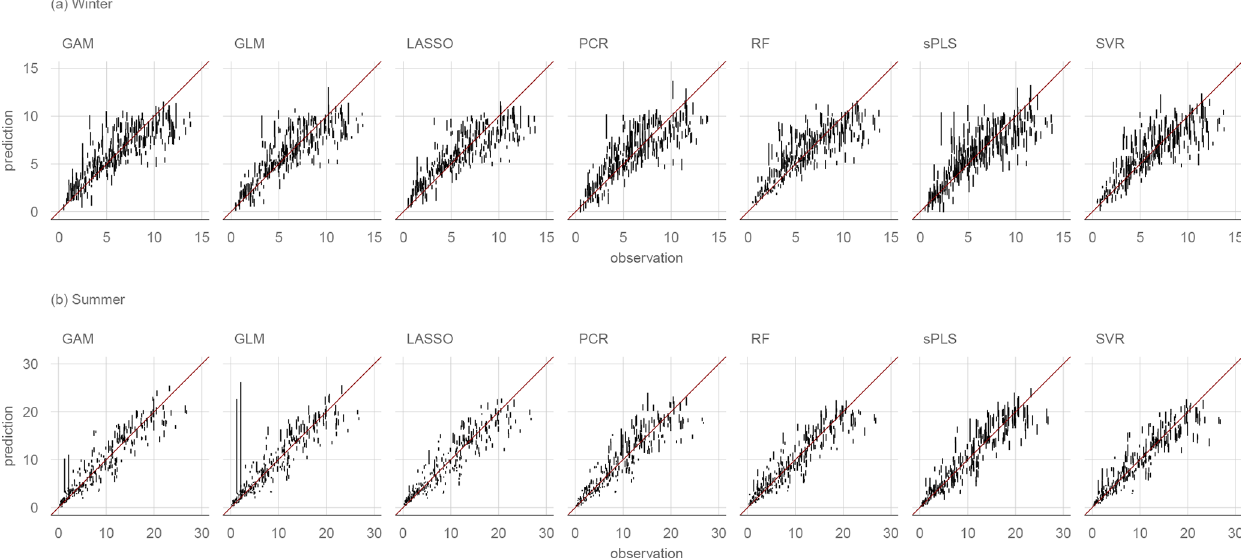
Figure A1. Error bars showing the range of predictions of the 10 CV runs for each model without variable preselection. Two outliers are not shown for the summer PCR model and the winter GLM, PCR, lasso, and GAM models to improve visual clarity.